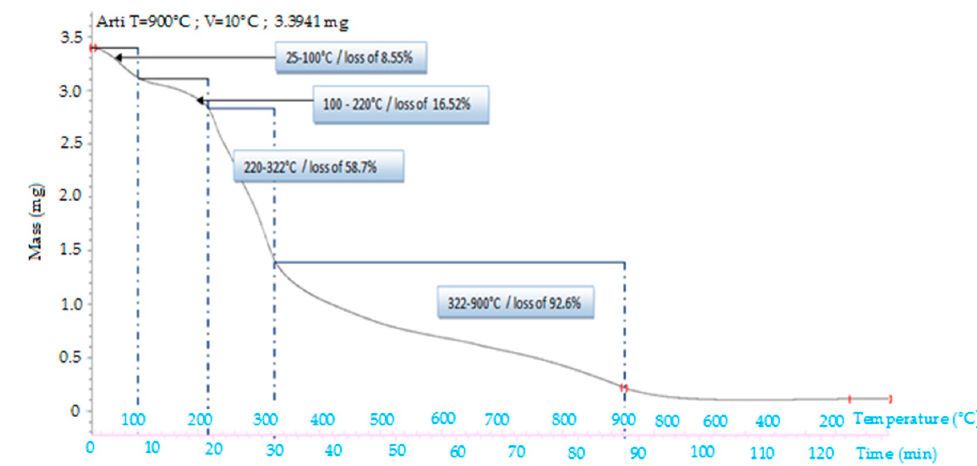
Figure 7. Thermo Gravimetric Analysis (TGA) of raw artichoke leaves powder (ALP).